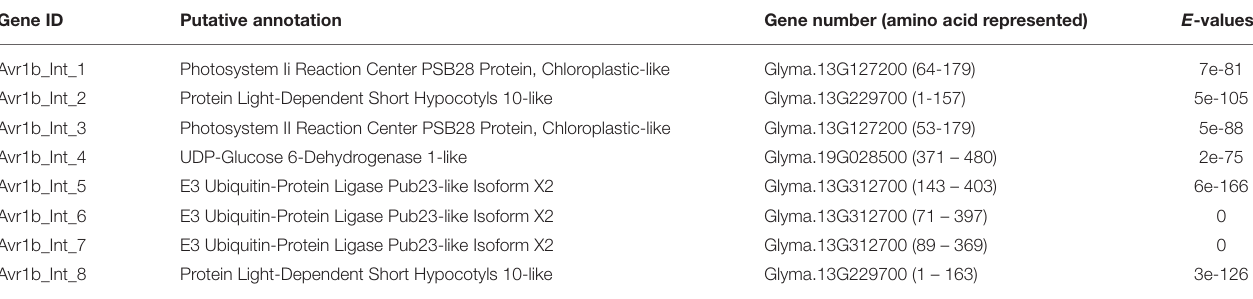
TABLE 1 | Soybean proteins that showed in vivo interactions with Avr1b in